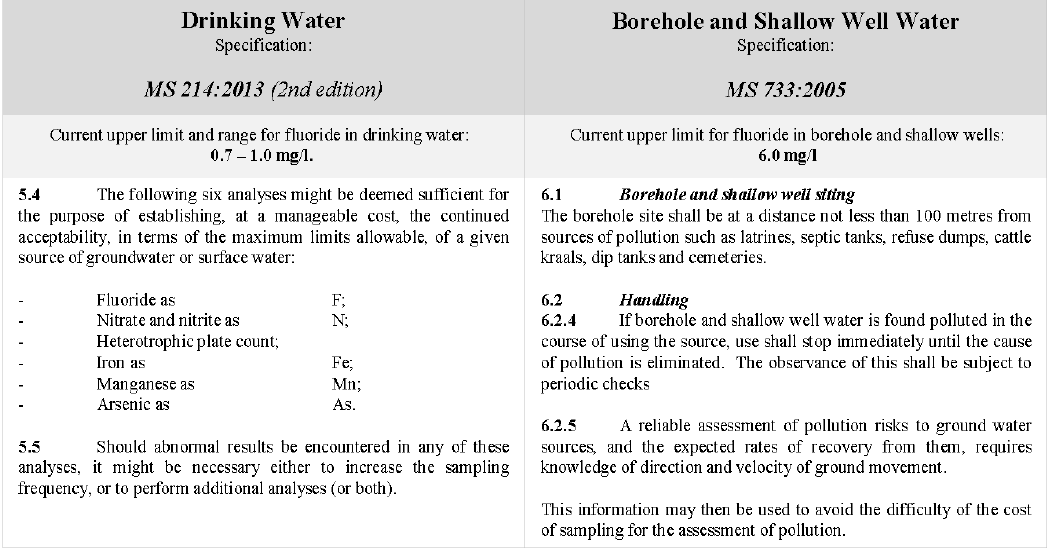
Figure 8. Summary of fluoride-relevant information from Malawi standard documents for drinking water and borehole and shallow well water